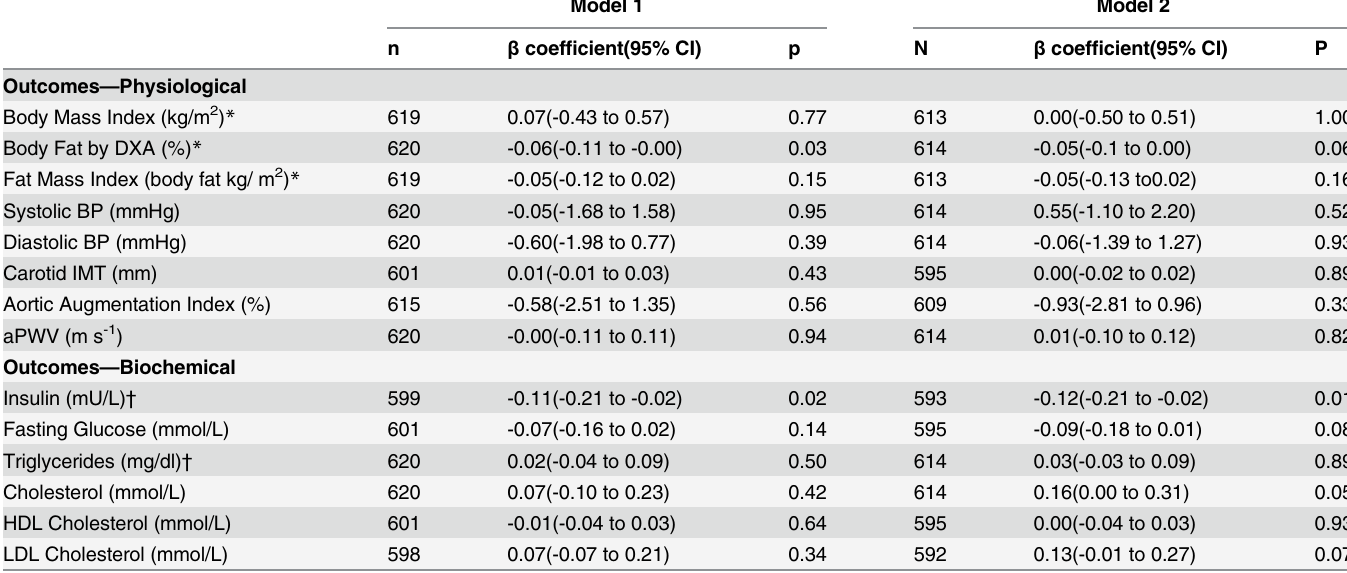
Table 3. Association of serum vitamin D (25(OH)D) † with cardiovascular risk factors in a sample of young Indian males from the Andhra Pradesh Children and Parents Study (n = 620) Ф ; 2009 –